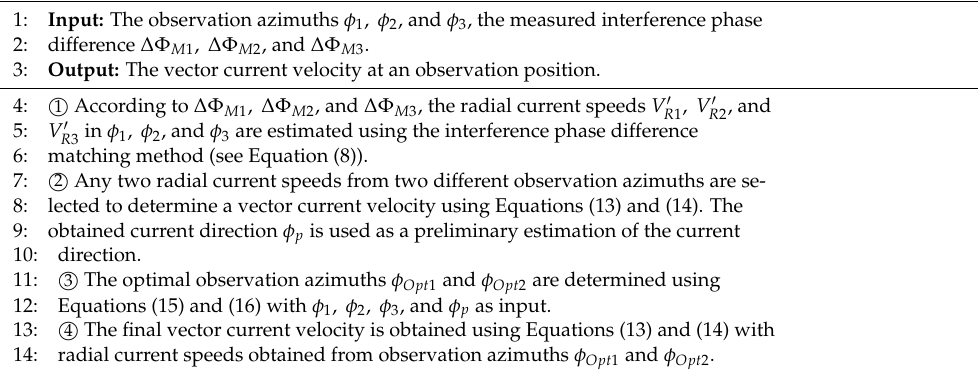
Algorithm 2 Vector current velocity estimation based on optimally selected observation